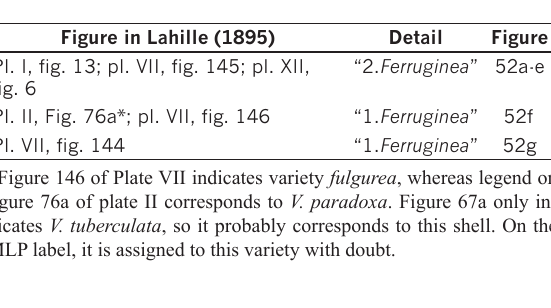
Table 22. Specimens of Voluta tuberculata ferruginea figured by Lahille (1895) with the detail of the inscriptions on their shells and figures here.